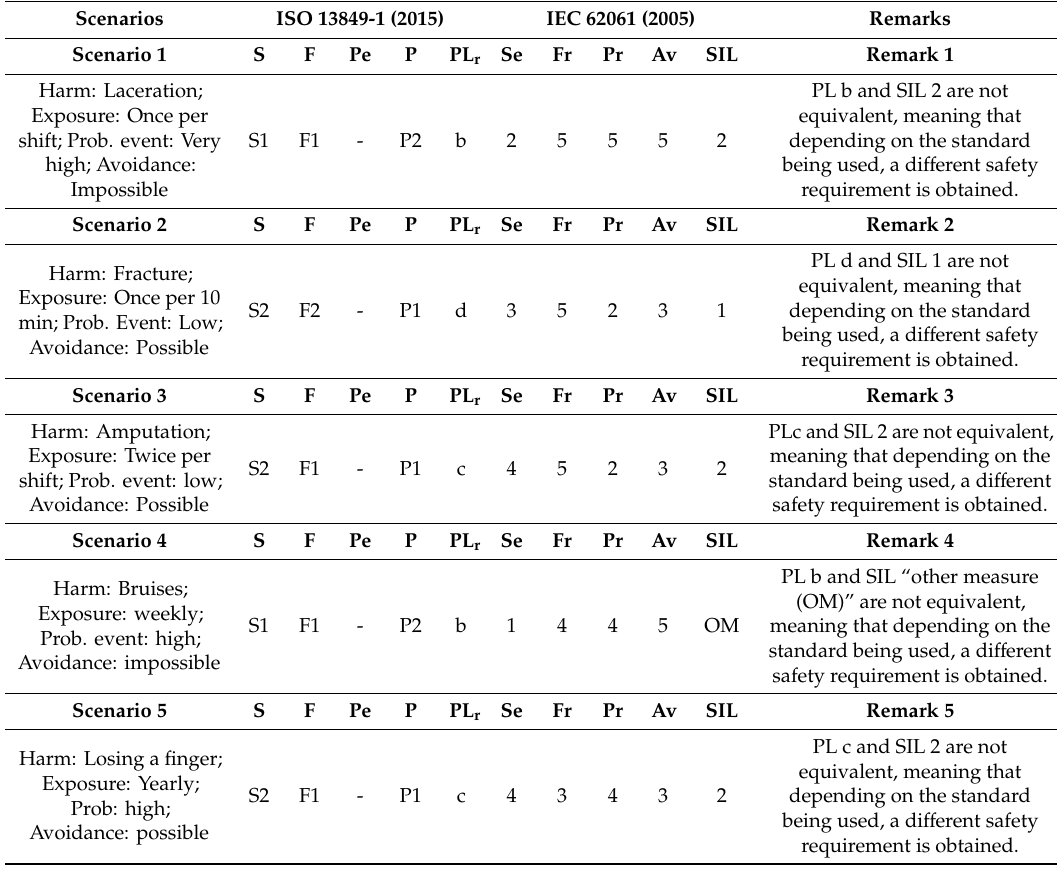
Table 6. Theoretical test scenarios based on the two standards.